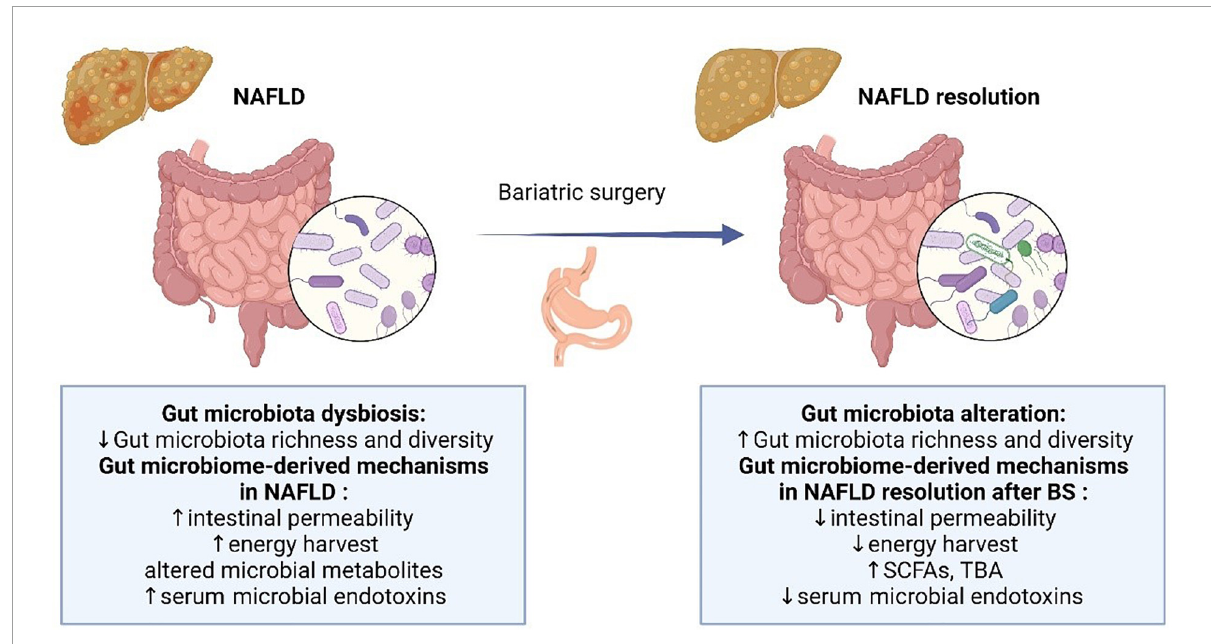
FIGURE1 Overview of the gut microbial alteration and microbiome-derived mechanisms in NAFLD and after BS. NAFLD, non-alcoholic fatty liver disease; SCFA, short-chain fatty acids; TBA, total bile